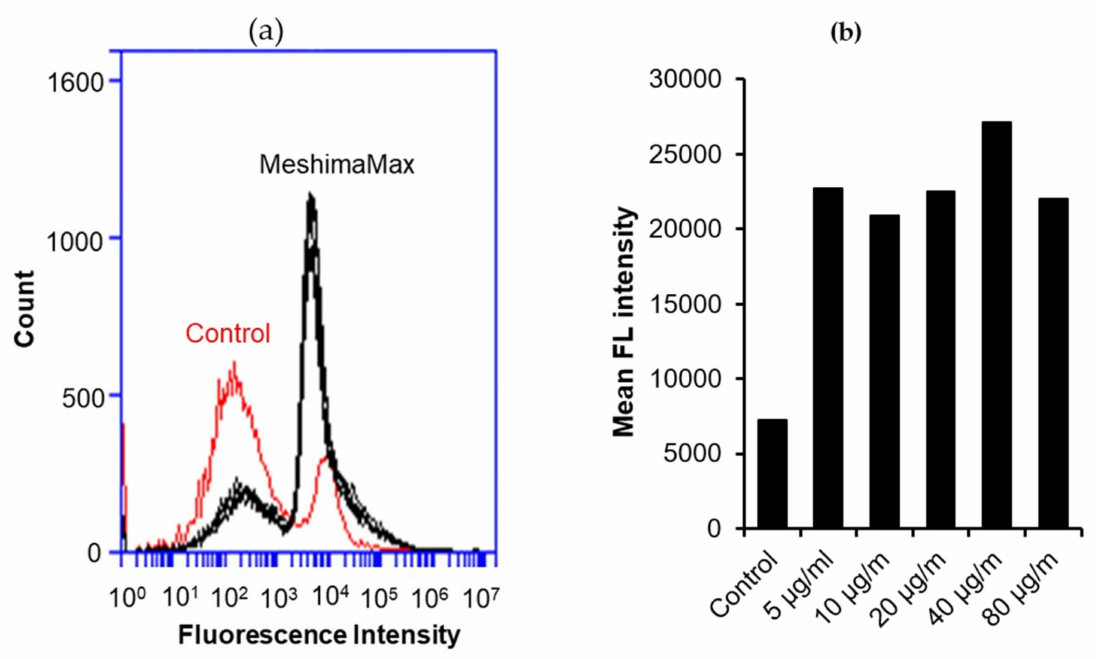
Figure 7. Internalization of fluorescence nano-beads by macrophages under the treatment of MeshimaMax. The flow cytometry results are shown in ( a ) where MeshimaMax treatment induced a remarkable shift to a higher fluorescence intensity than untreated controls indicating that more nano-beads were taken up by macrophages. The mean fluorescence intensities of macrophages treated by di ff erent concentrations of MeshimaMax are shown in ( b ). See text for